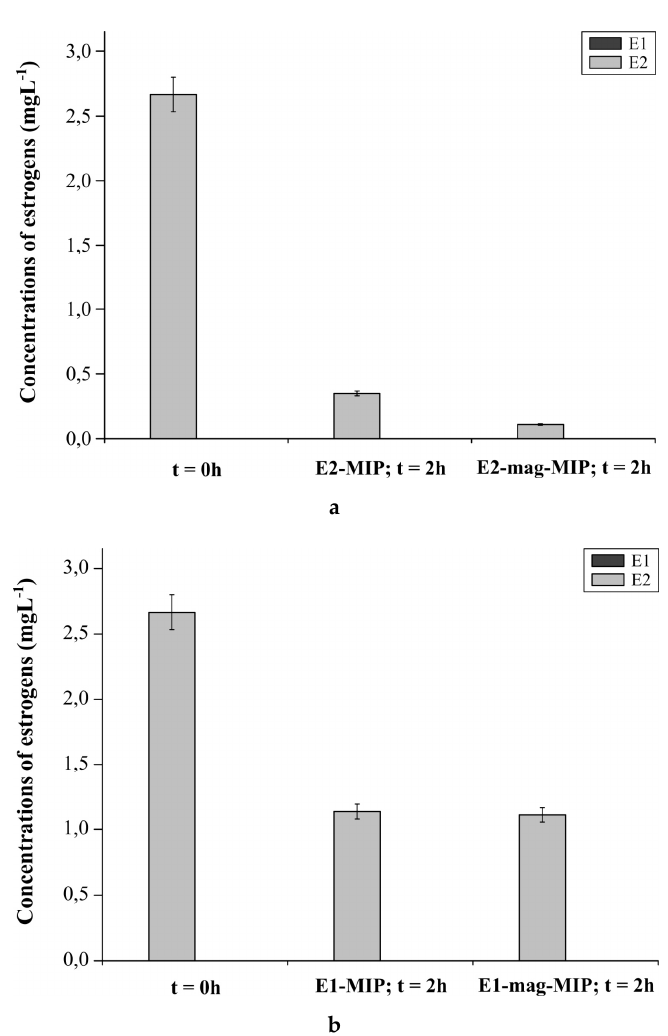
Figure 7. ( a ) Concentration of E1 and E2 in E2 aqueous solution before addition of the materials and 2 h after the addition of E2-MIP and E2-mag-MIP. ( b ) Concentration of E1 and E2 in E2